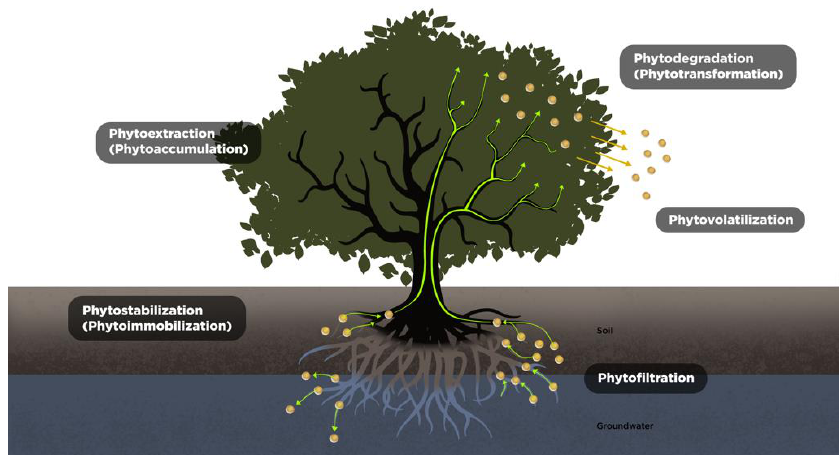
Figure 2. Schematic representation of phytoremediation